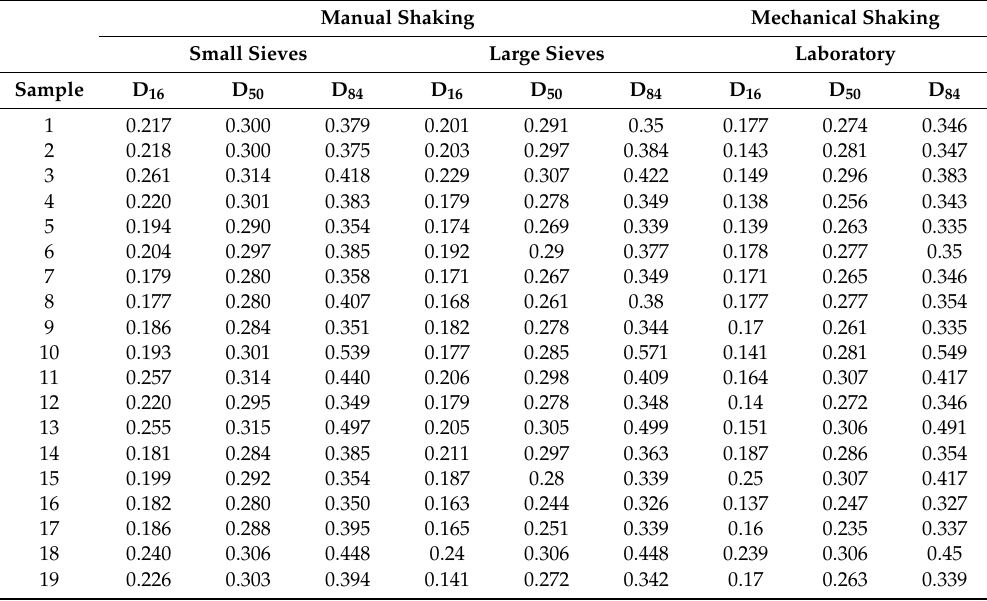
Table 1. Values of the parameters D 16 , D 50 and D 84 , obtained by three di ff erent methods, for the 19 samples taken from the dredger